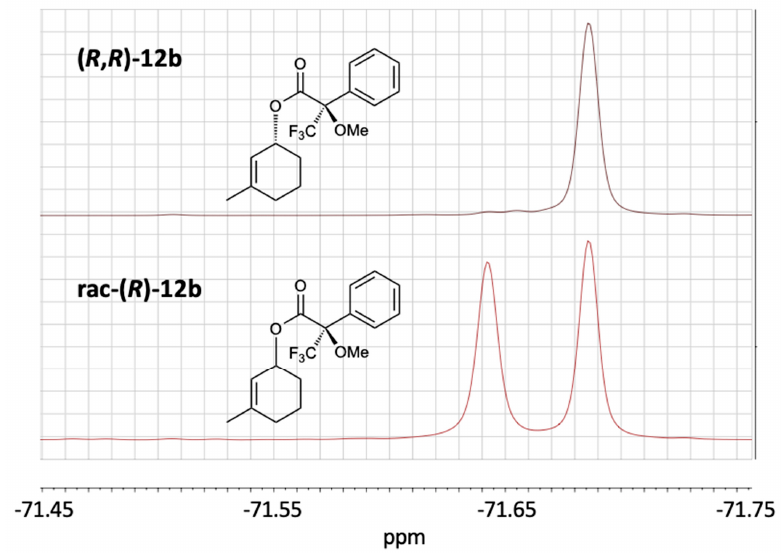
Figure 2. 19 F NMR spectra of Mosher esters ( R,R )-12b and rac ,( R )-12b obtained from rac -3b and ( R )-3b . for the 19 F NMR spectra of Mosher esters ( R,R )-12c-n see Table 1 and Supporting